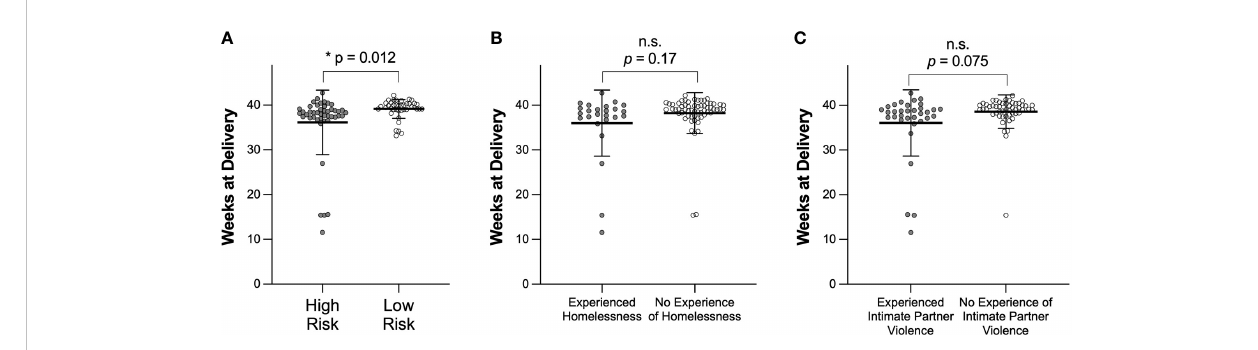
FIGURE 1 Comparison of weeks of pregnancy at time of delivery based on (A) clinical designation of high or low risk, (B) experience of homelessness, or (C) experience of intimate partner violence. Data are shown as mean ± SD. Signi fi cance was determined using a t test with Welch ’ s correction. n.s. indicates not signi fi